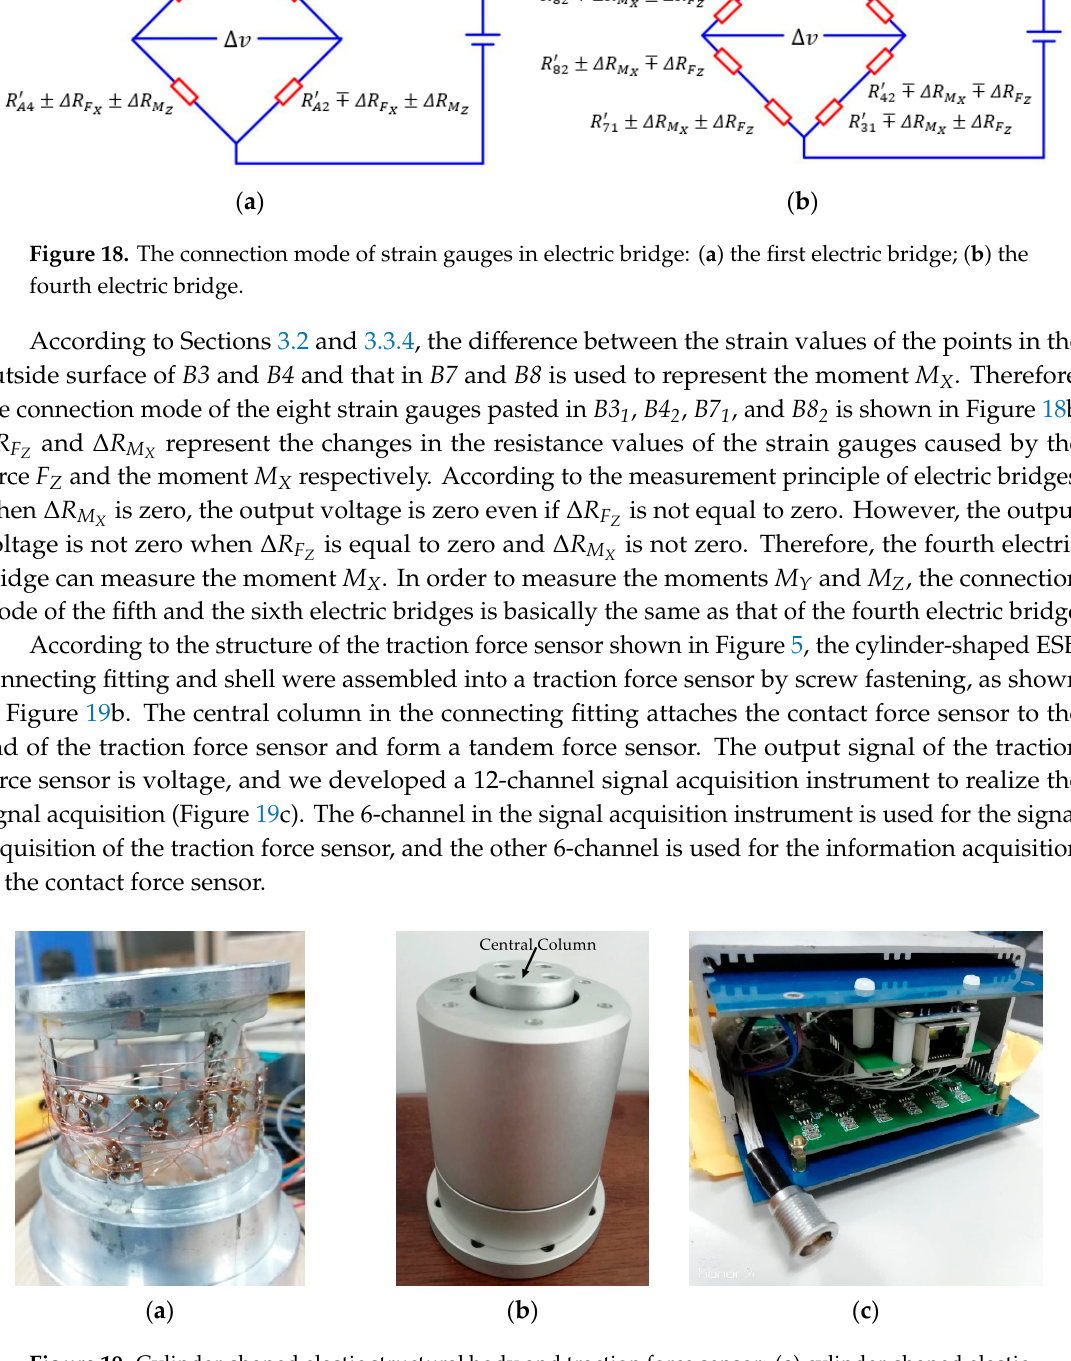
Figure 19. Cylinder-shaped elastic structural body and traction force sensor: ( a ) cylinder-shaped elastic structural body; ( b ) traction force sensor; ( c ) signal acquisition instrument.